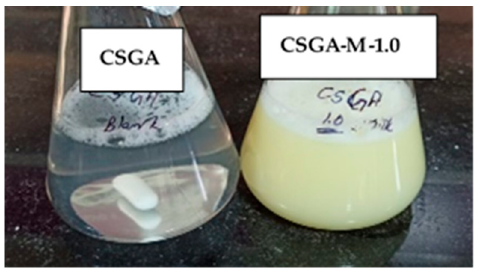
Figure 1. Blank and mancozeb-loaded CSGA nanocomposites.